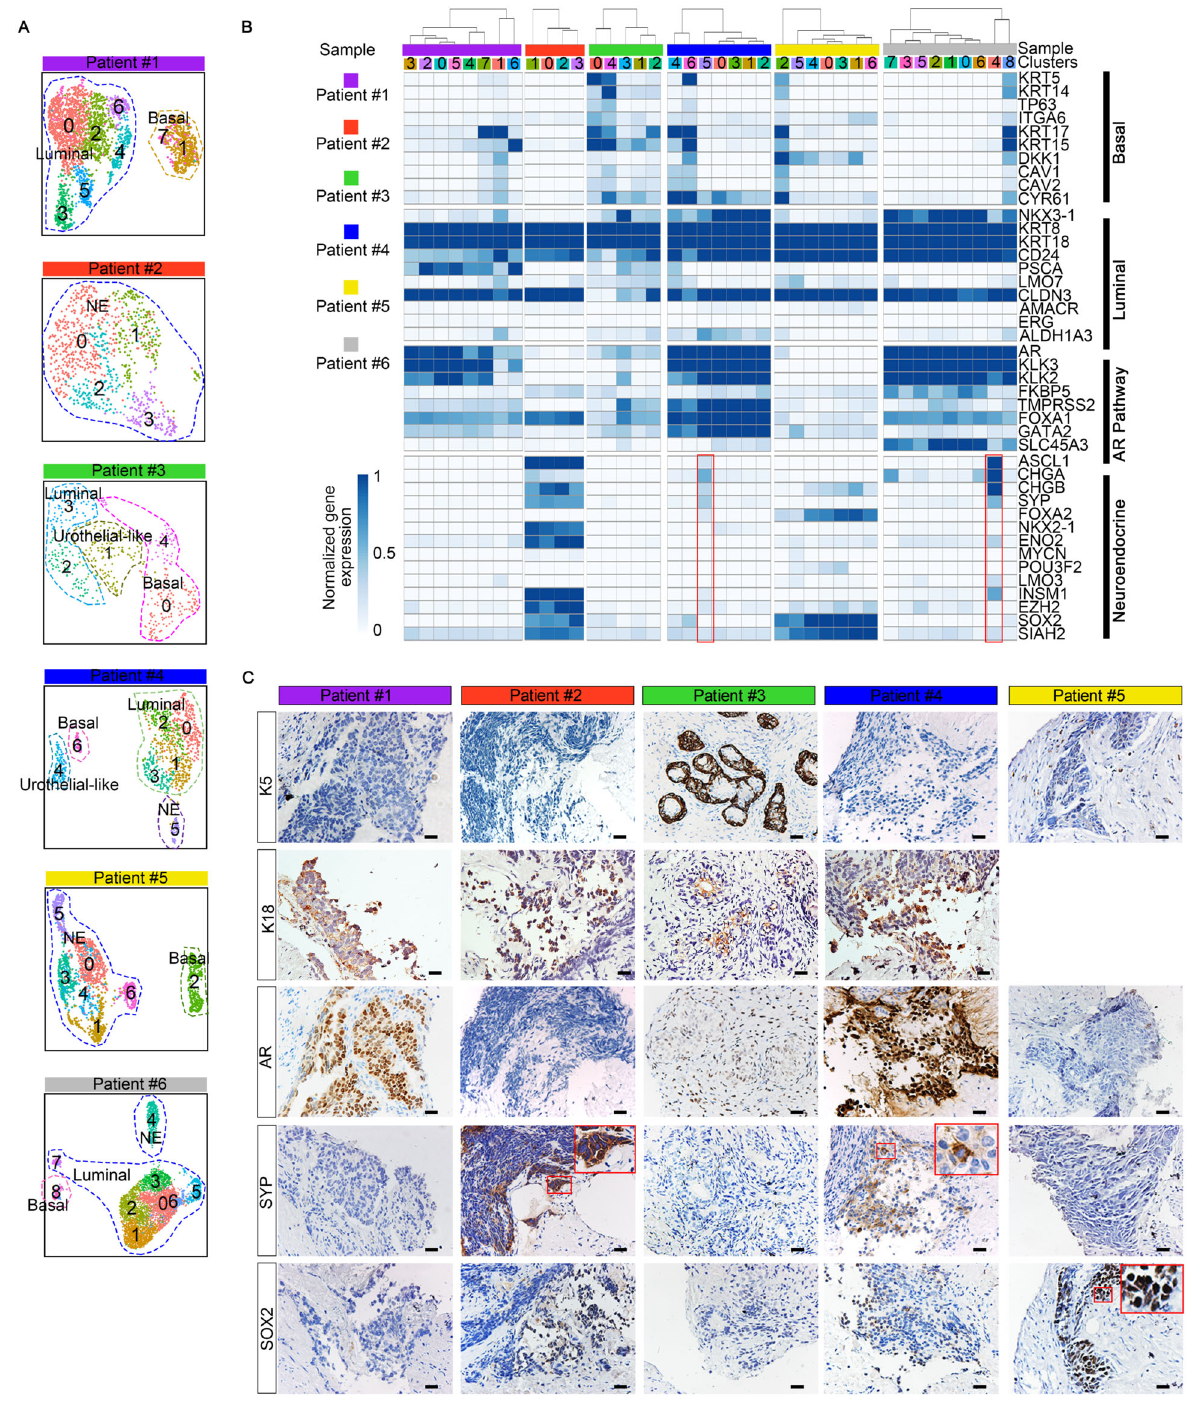
Fig. 3 Intratumor heterogeneity analyses reveal different extents of NE differentiation. A UMAP visualization of epithelial cell sub-clusters from each sample. B Heatmap depicting prostate lineage marker genes and AR pathway gene expression levels in epithelial cell sub-clusters from each sample. Those highlighted in red frame showed cluster 5 in patient #4 and cluster 4 in patient #6 was NE sub-clusters. C Immunohistochemistry (IHC) staining for K5, K18, AR, SYP, and SOX2 in sections from fi ve samples. Scale bars represent 50 μ